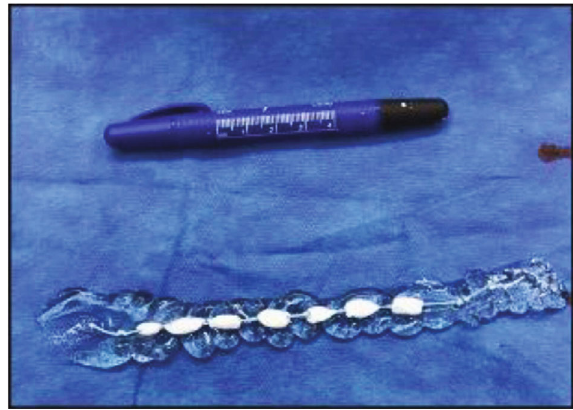
Figure 4: Surgeon made antibiotic-coated Polymethyl methacrylate (PMMA) beads surrounded by metronidazole gel.